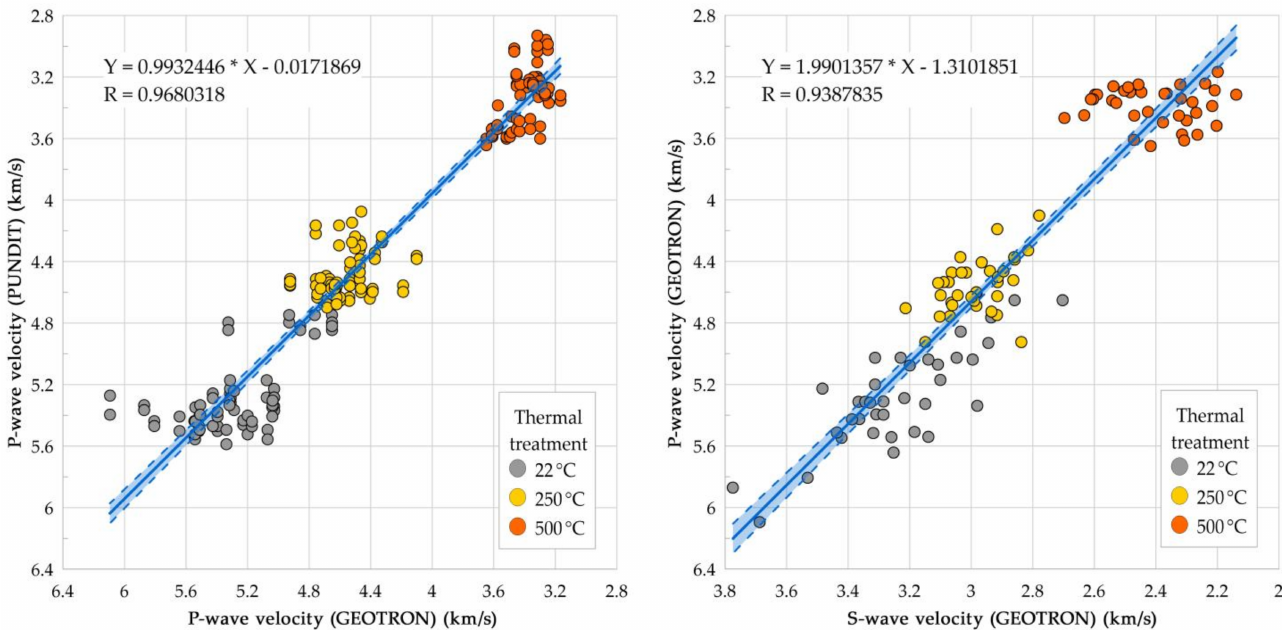
Figure 12. Scatter plots of different ultrasound velocities among heat-treated groups. Scatter plot of P-wave velocity values between PUNDIT and GEOTRON devices ( left ). Scatter plot of P-wave and S-wave velocity (GEOTRON device) values ( right